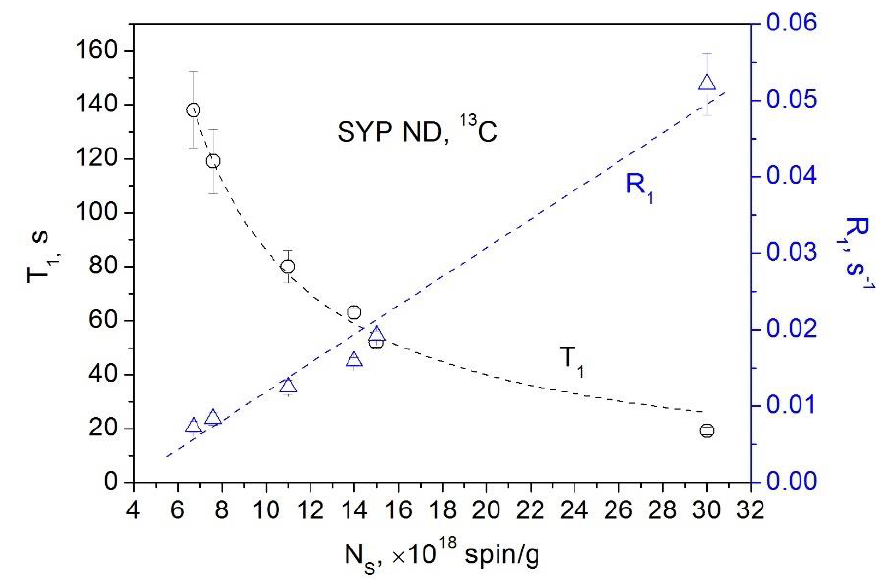
Figure 9. Dependence of the 13 C spin–lattice relaxation rate R 1 (triangles) and the spin–lattice relaxation time T 1 (circles) in SYP nanodiamond powders on the concentration of the paramagnetic defects. Hyperbolic-like concentration dependence of T 1 was recently obtained in measure- ments of the 1 H spin–lattice relaxation of aqueous solutions of nanodiamonds of 18 and 125 nm in diameter prepared by the HPHT technique